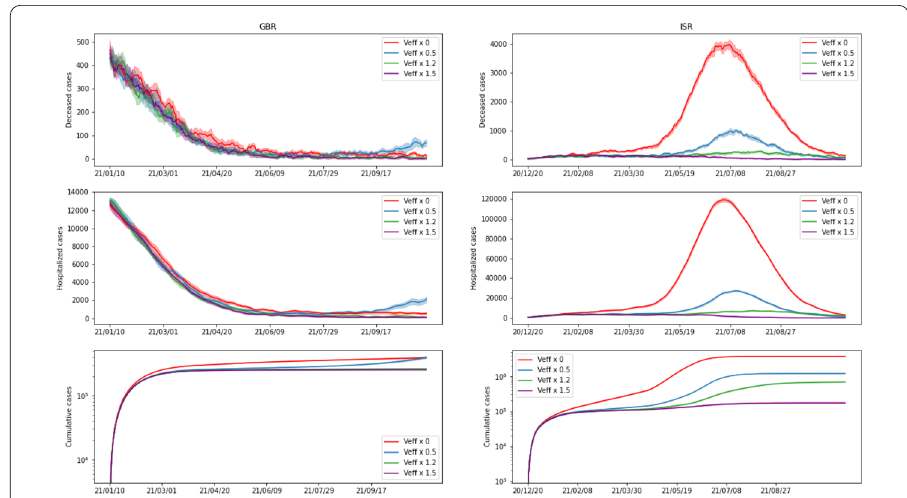
Figure 10 Scenario6 . Comparison of simulations with different vaccine efficacy, where k is a factor multiplied by the estimated value found in our estimate. All other settings remain the same. We present cumulative cases, hospitalized and deceased for both GBR (on the left) and ISR (on the right). Note that the simulation starts only on the first day of the vaccination campaign for each country